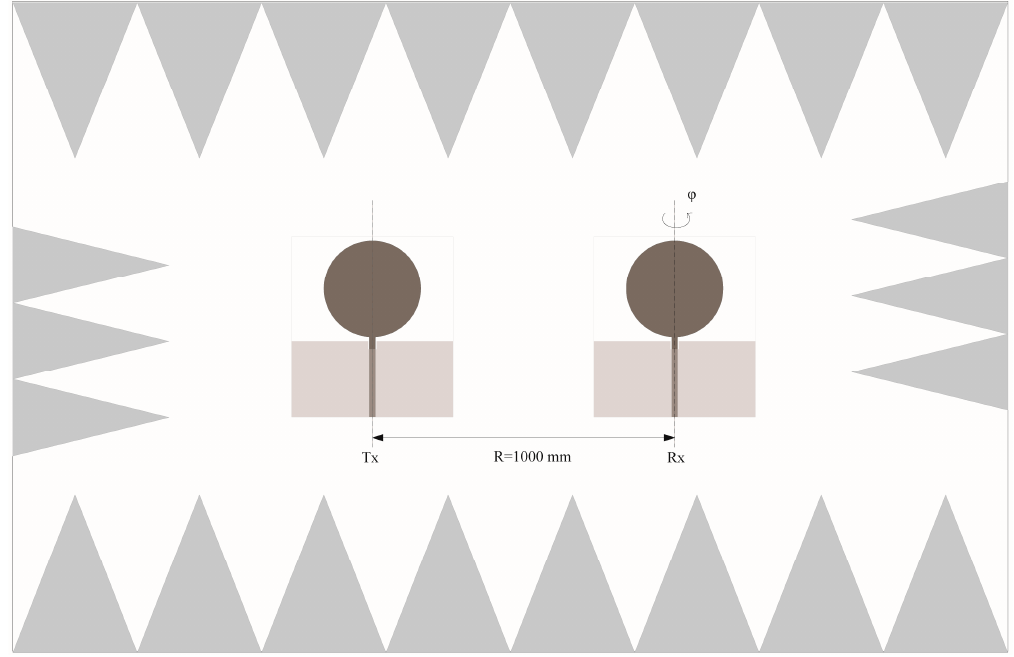
Figure 10. Measurement setup inside an anechoic chamber (Transmitted (Tx), Received (Rx)).